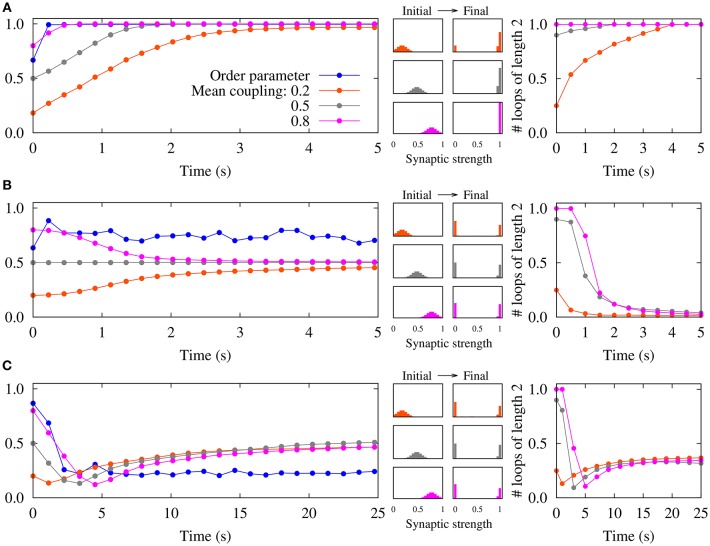
Emergence of different connectivity patterns in a recurrent network of spiking neurons mediated by STDP. (Left panels) Simulated order parameter and time course of three different mean couplings of weight distributions. (Middle panels) Initial Gaussian distribution around different mean values and final distribution of the synaptic strengths. (Right panels) Time course of the normalized number of closed loops of length 2 measuring the number of two-neuron loops in the network (Madadi Asl et al., 2017). (A) The synaptic strengths are potentiated and bidirectional connections are significantly enhanced in the inphase firing when τd = 0.5ms>τa = 0.3ms. (B) STDP breaks strong two-neuron loops and results in unidirectional connections in nearly inphase firing when τd = τa = 0.5ms. (C) A loosely connected network is achieved where bidirectional loops are eliminated in the nearly antiphase firing when τd = 0.5ms < τa = 1.0ms. STDP parameters are A+ = A− = 0.005, and τ+ = τ− = 10ms. Figure partly adopted from Madadi Asl et al. (2017) with authors' permission.